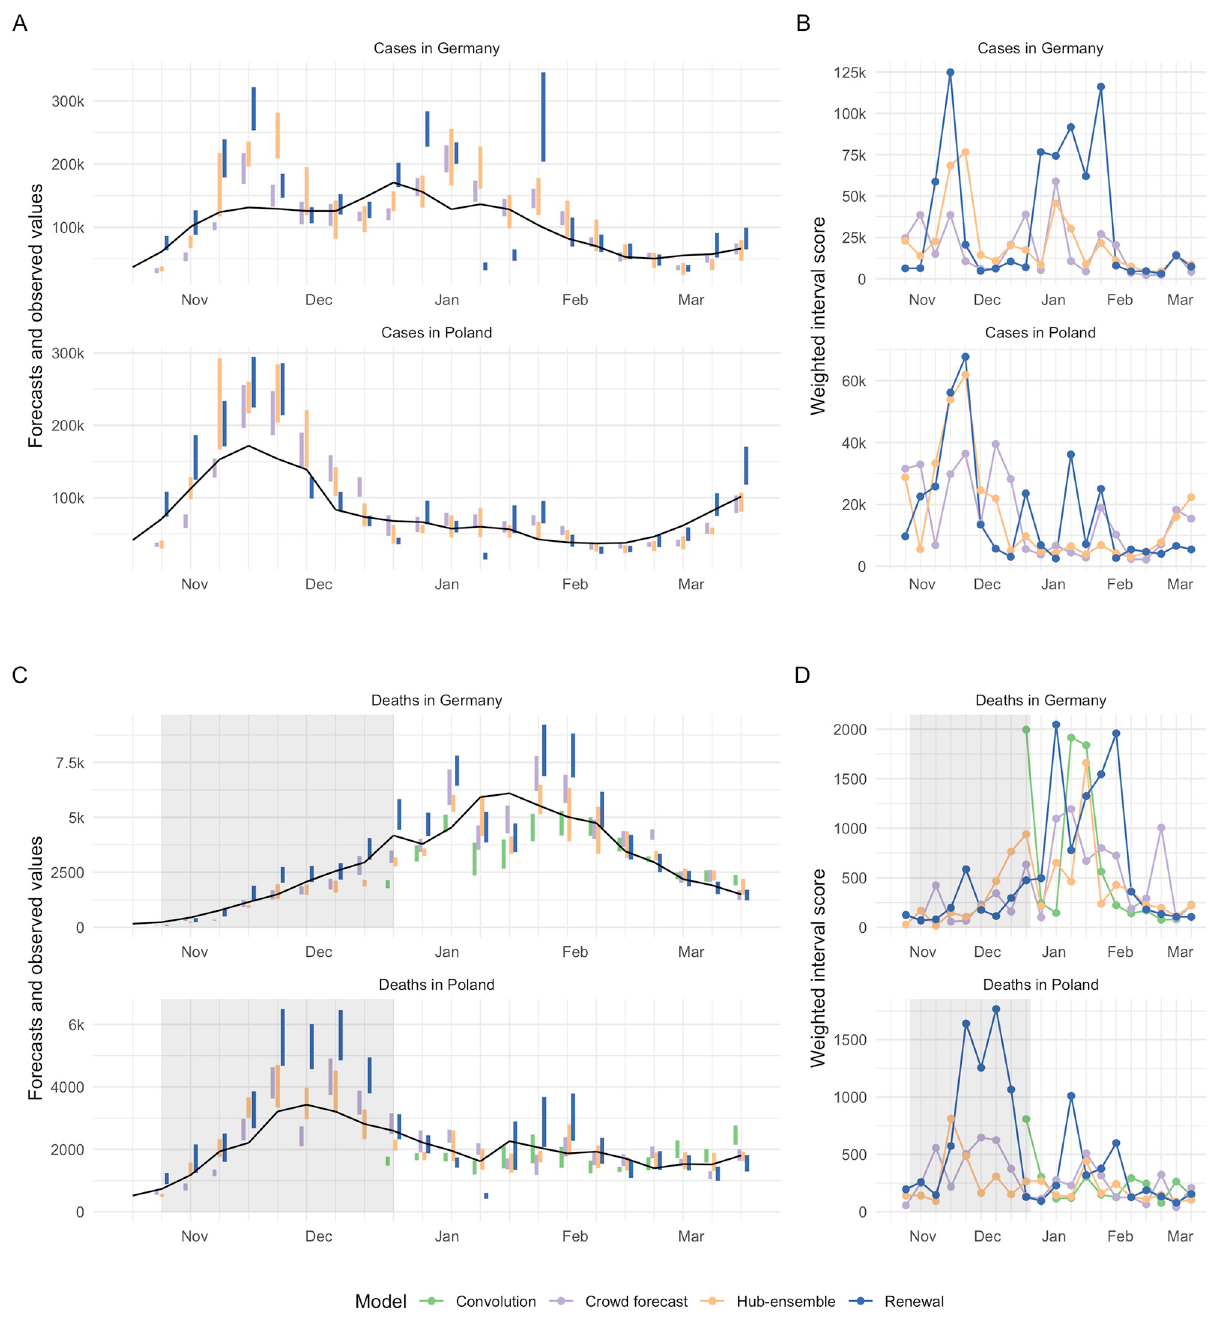
Fig 3. Distribution of scores. A: Distribution of weighted interval scores for two week ahead forecasts of the different models and forecast targets. Points denote single forecasts scores, while the shaded area shows an estimated probability density. B: Distribution of WIS separate by country. Black squares indicate median and black circles mean